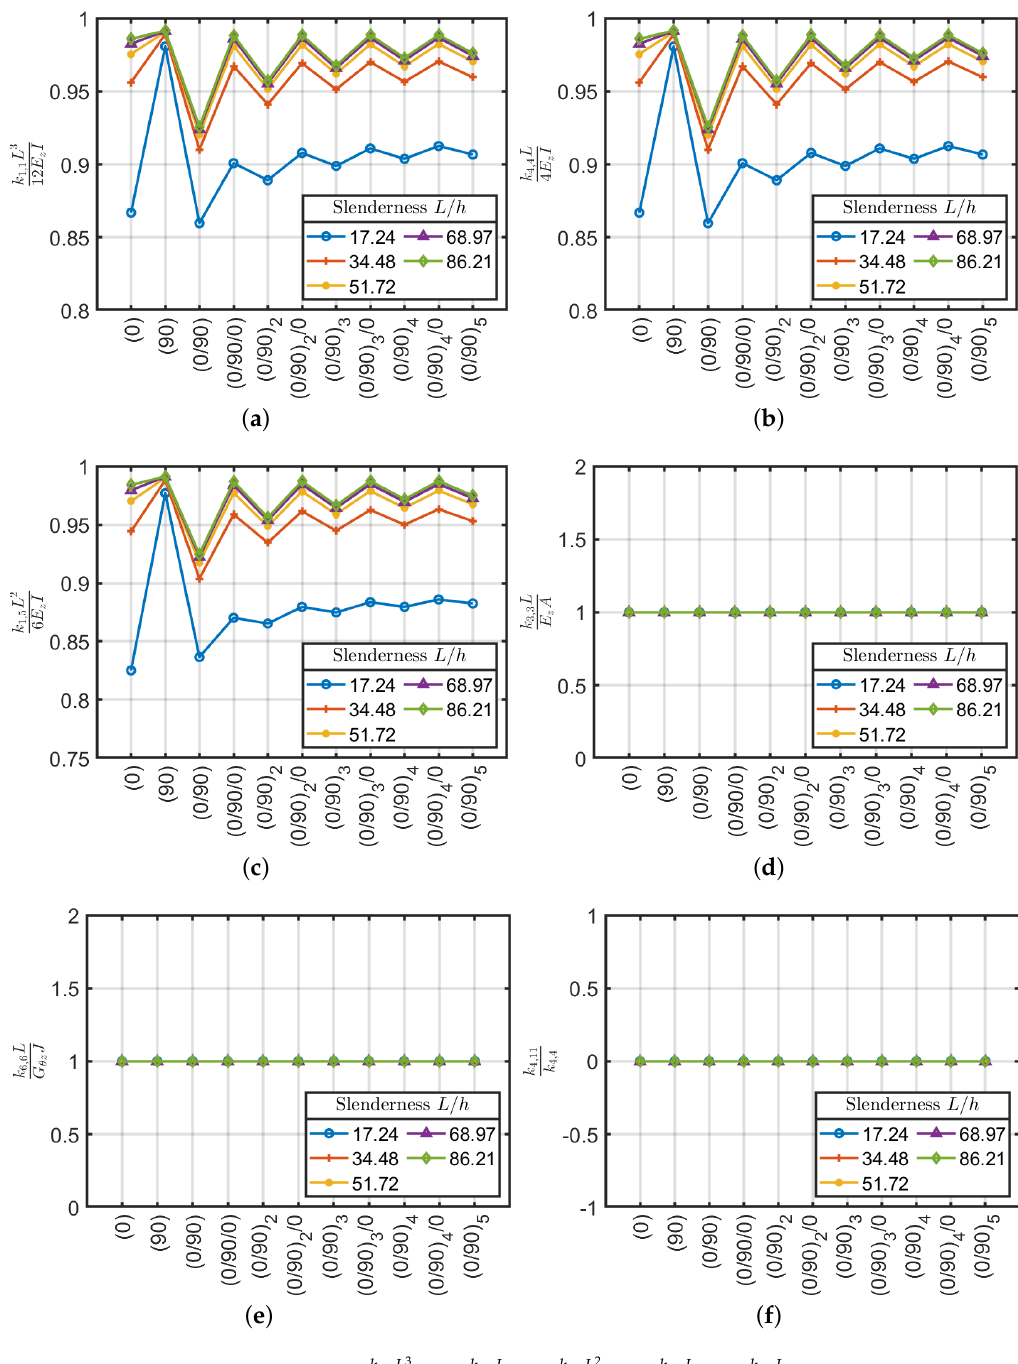
Figure 7. Stiffness coefficients ( a ) k 1,1 L function of slenderness L / h for cross-ply